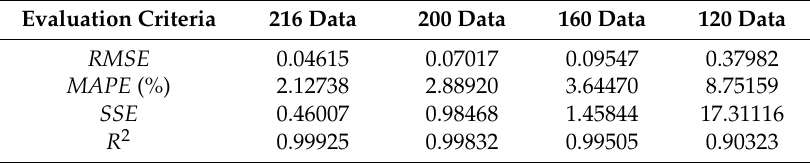
Table 8. Performance evaluation of the RBF neural network with different viscosity data.